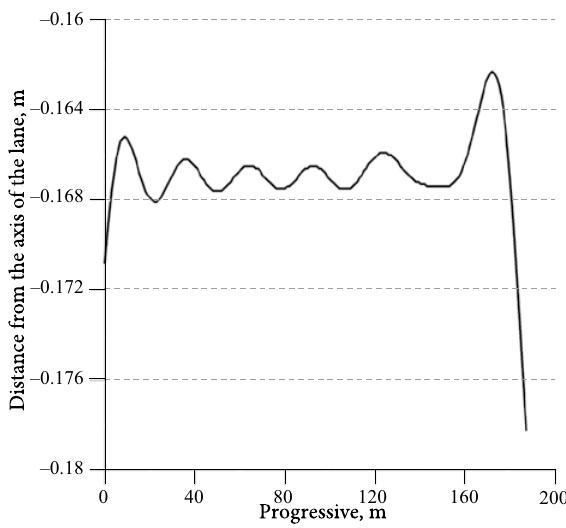
Fig. 9. Position of the vehicle respect to the centre line of the lane to verify the presence of